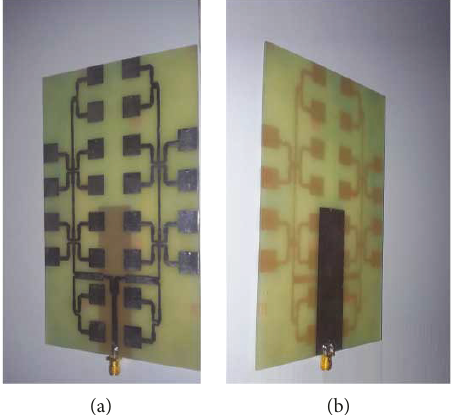
Figure 13: Geometry of realized UWB array antennas. (a) Rectangular radiating elements in the top view of array antennas. (b) Partial ground plane in the bottom view of array